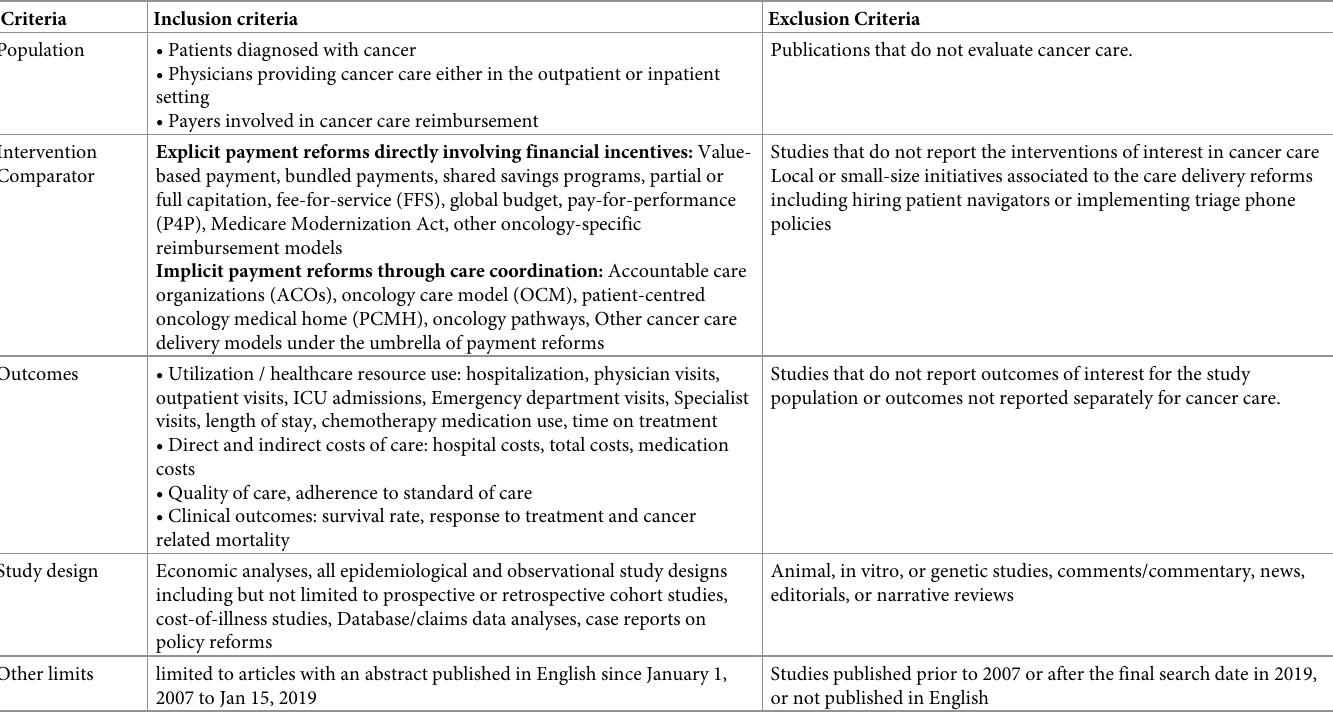
Table 1. PICOT inclusion and exclusion criteria for study selection in the